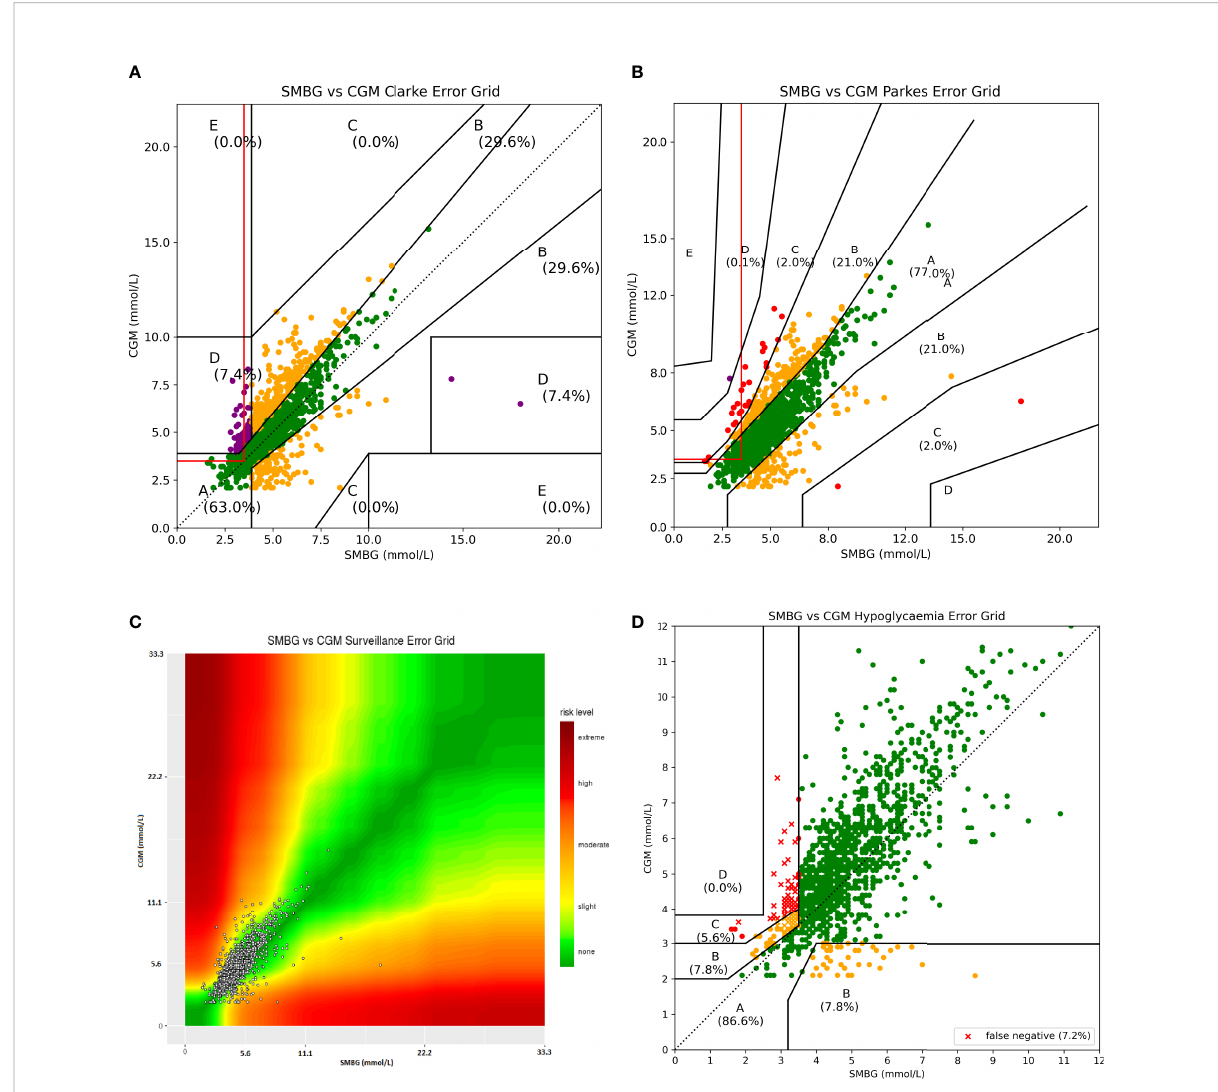
FIGURE 6 All four error grids plotted with 1441 paired values from CHI dataset. The red lined box in (A, B) indicates false negatives for hypoglycaemia. Several glucose datapoints in this box on the CEG (53) and PEG (84) would be classi fi ed as no risk but would potentially pose a risk to a patient with CHI. In plot (C) , due to a lack of colouring of the plots, categories are less de fi ned than in a grid model. Data points appear clustered in the left lower corner as numerical values on x and y axis are immovable by software constraints. For the HEG (D) 4.7% of values have been classi fi ed as moderate risk to the patient; these represent an over reading by the CGM device at a time of hypoglycaemia (<3.5mmol/L). There are no false negatives classed as no risk. False negatives are differentiated in representation by being plotted as a cross rather than a